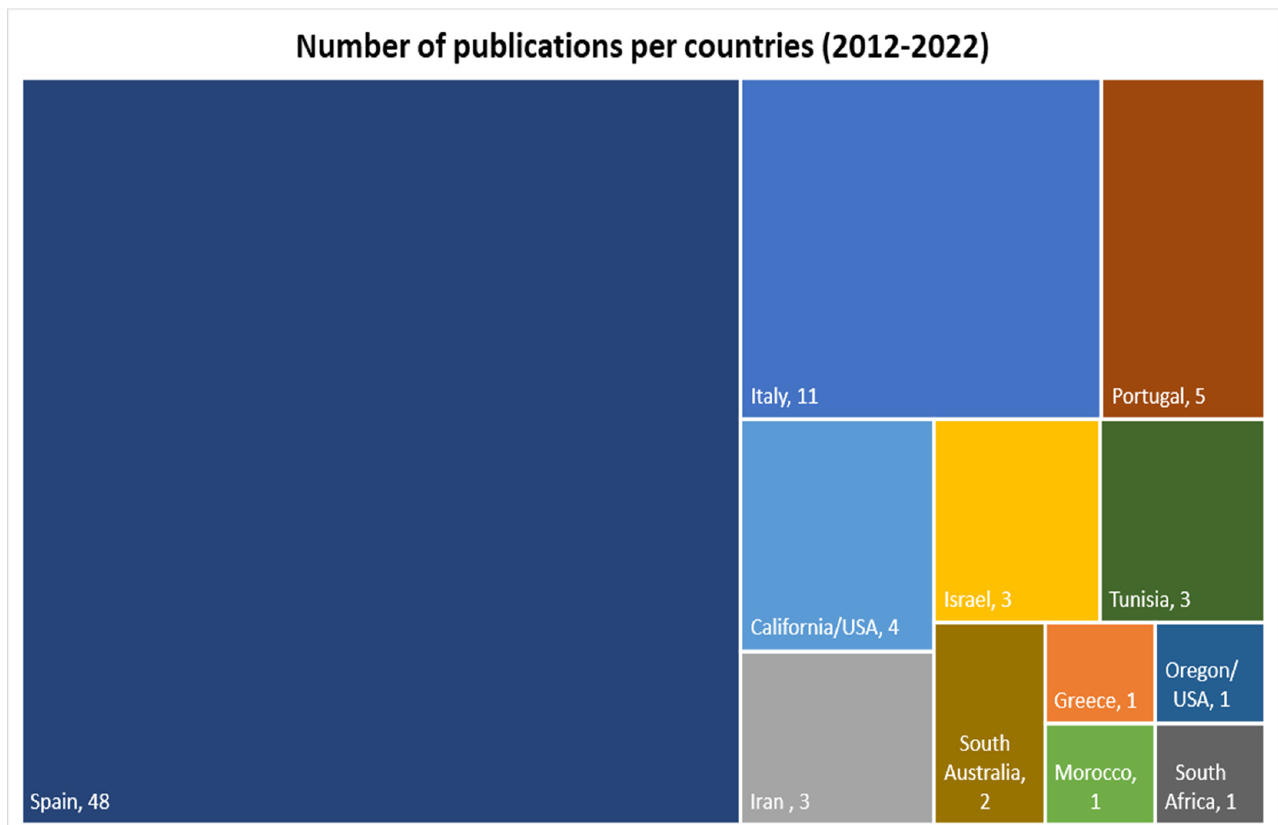
Figure 4 . Number of publications per country of the application of the different sensors and methodologies from 2012 till 2022 for Mediterranean fruit and tree crops.